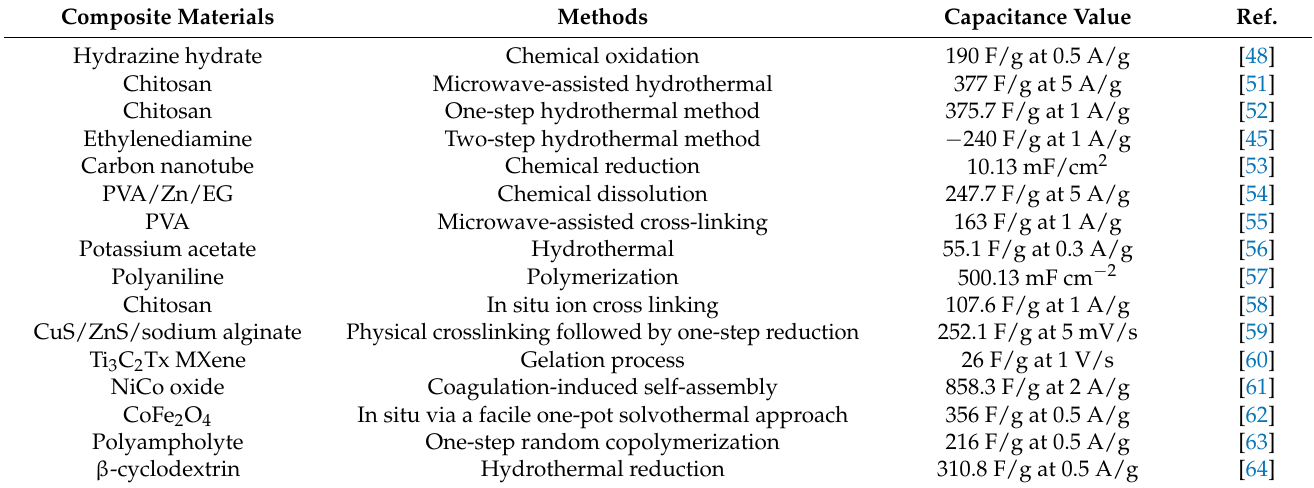
Table 1. Comparison of supercapactive performance of graphene-based